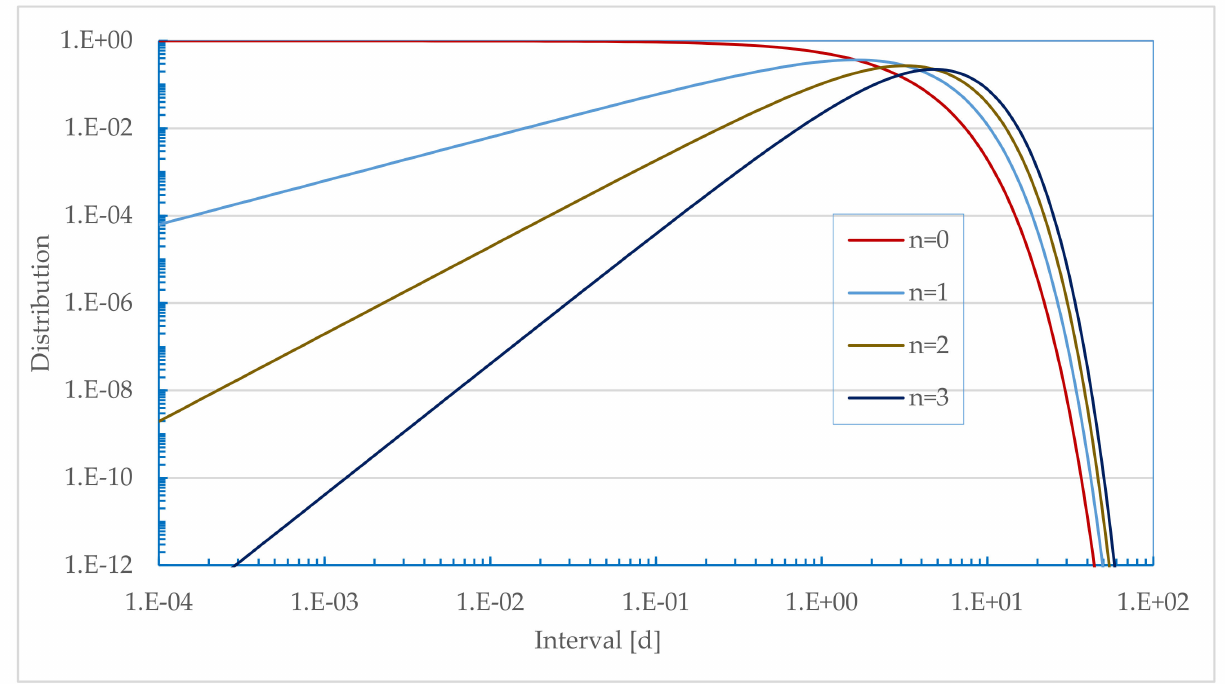
Figure 10. The distribution P n ( T ) of having n failure-occurrences with the interval T , for n = 0, 1, 2,